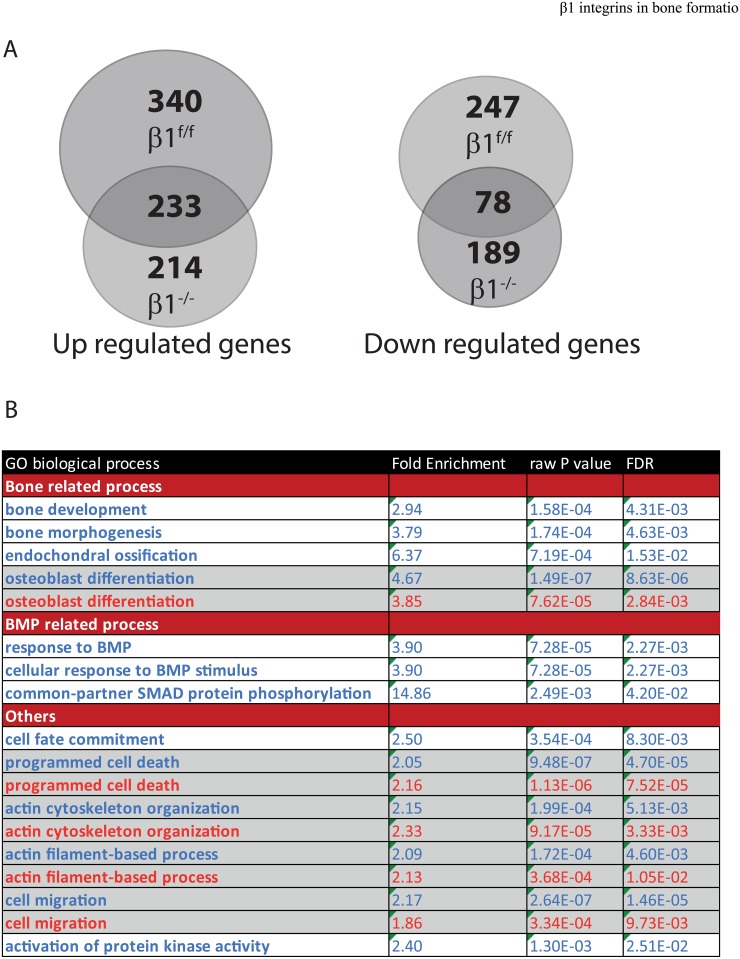
Transcriptomic analyses of BMP2 response.A. Diagrams representing the number of up and down regulated genes in control and β1 deficient cells in response to BMP2 stimulation, respectively. B. Amigo2 online software analysis of GO biological process modified upon BMP2 treatment in control (blue) and β1 deficient cells (red). Biological processes were selected based upon biological interest (bone related signature). FDR = False Discovery Rate.